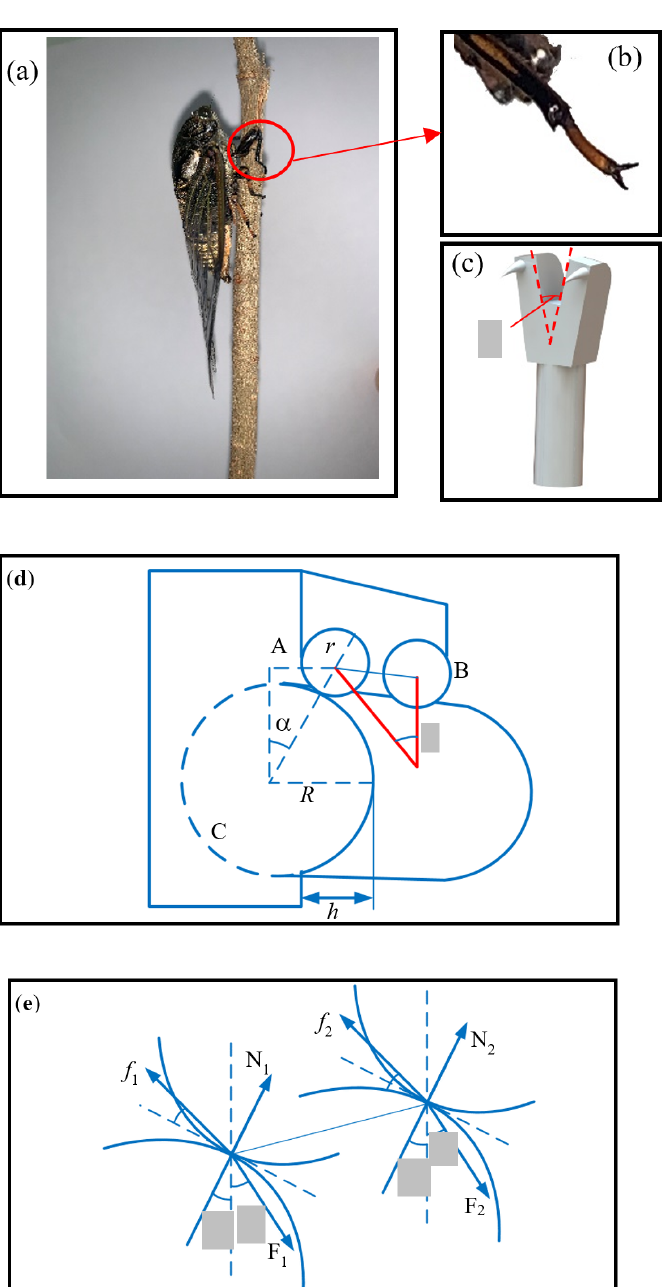
Figure 5. ( a ) A cicada on the branch of the tree, ( b ) a leg of a cicada, ( c ) the bionic bifurcated spines inspired by the cicada’s claws, ( d ) equivalent force diagram of the bionic hook. ( e ) The equivalent force diagram of the bionic hook adhering to the rough surface.